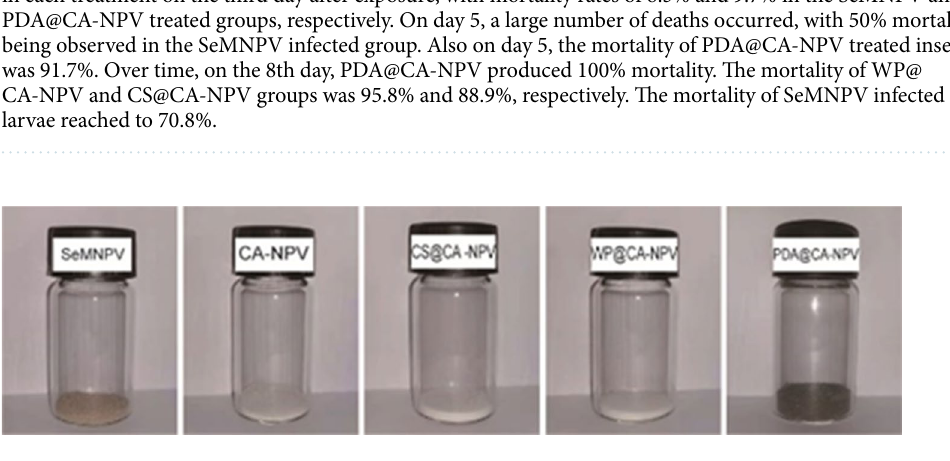
Figure 9. Microcapsule samples after freeze-drying were stored at room temperature. The microcapsules used for UV resistance experiments were at room temperature stored for 8 months in the glass